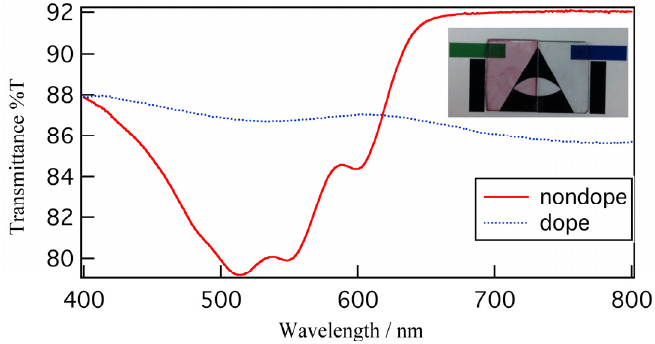
Figure 6. Transmittance dependence on film thickness of P3HT/PMMA nanofiber composite films at the peak absorbance wavelength (514.0 nm) before and after doping with AuCl